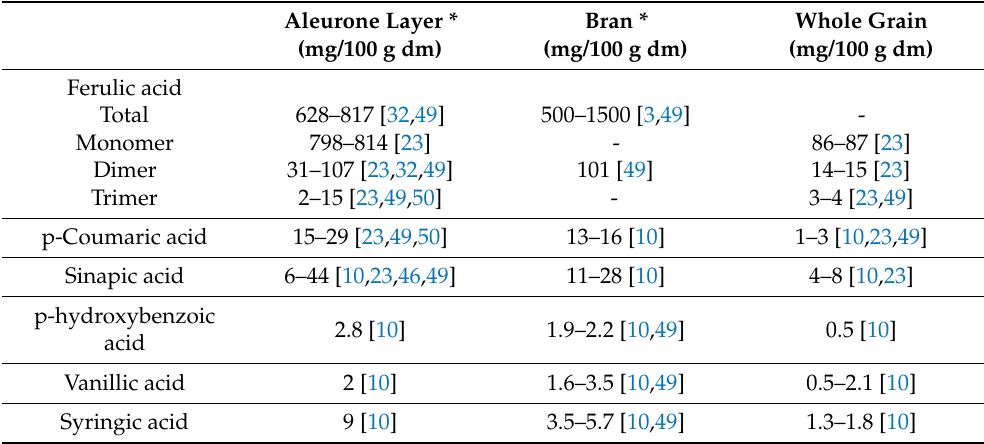
Table 2. Phenolic acids repartition in the wheat aleurone layer, bran and whole grain. Aleurone Layer